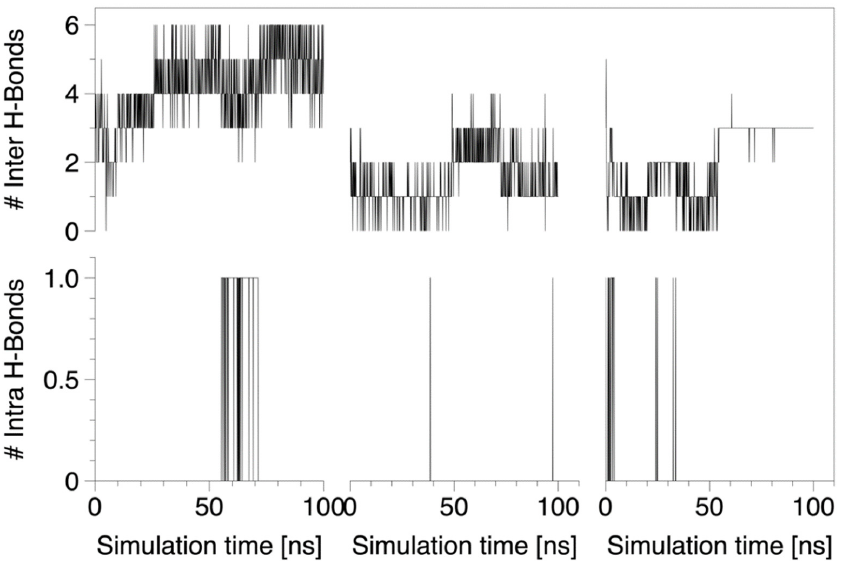
Figure 4. Number of inter ( Top ) and intra ( Bottom ) H-bond interactions observed during the simulations of compound 4 .